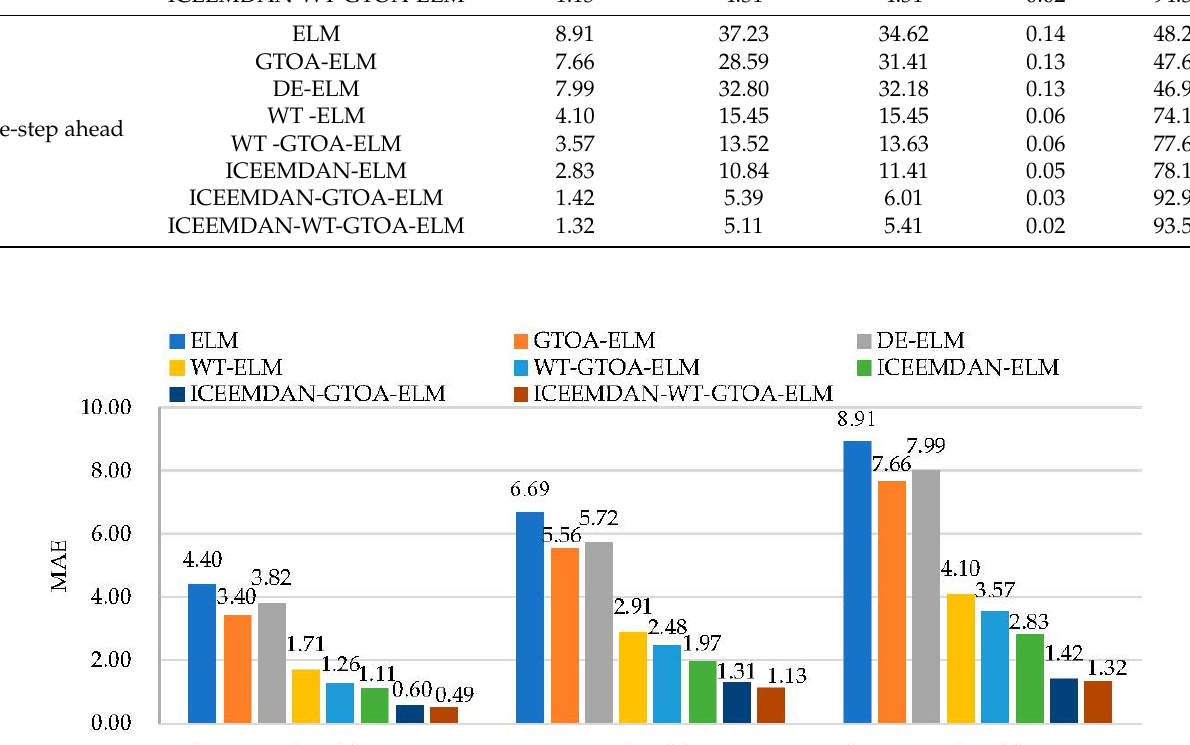
Figure 10. MAE of PM2.5 forecasting. Table 4. Forecasting error of PM2.5 concentration. Multistep Ahead